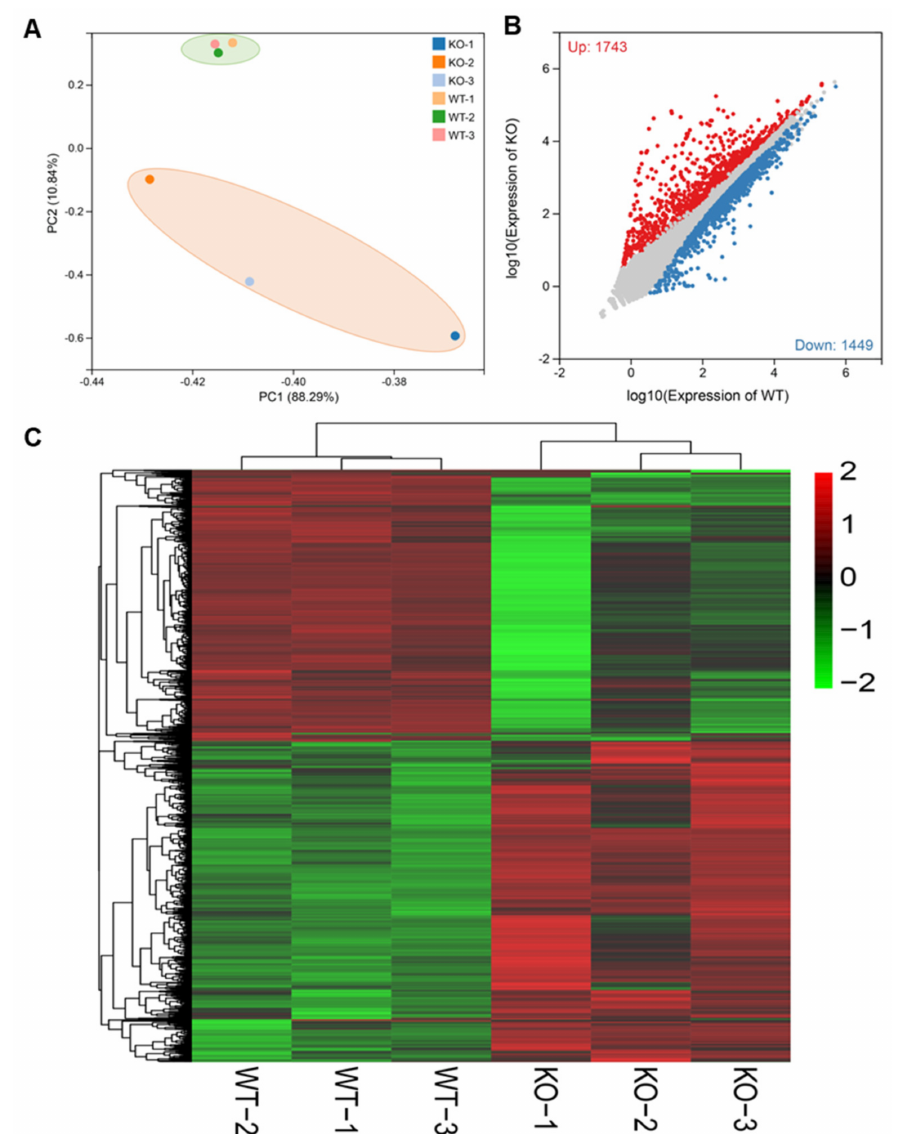
Figure 3. Depletion of BmMETTL4 led to great changes in transcriptome. ( A ) PCA of transcriptome data among different samples were analyzed by plotPCA function of DEseq2 program. ( B ) Statistical chart of DEGs in WT and KO-METTL4 mutant. The standard |log2(Fold Change)| > 0 and Padj < 0.05 were used to determine significant differences in gene expression. Red represents up-regulated genes, blue represents down-regulated genes, and gray represents genes without significant differences. ( C ) Heatmap visualization of DEGs between WT and KO-METTL4